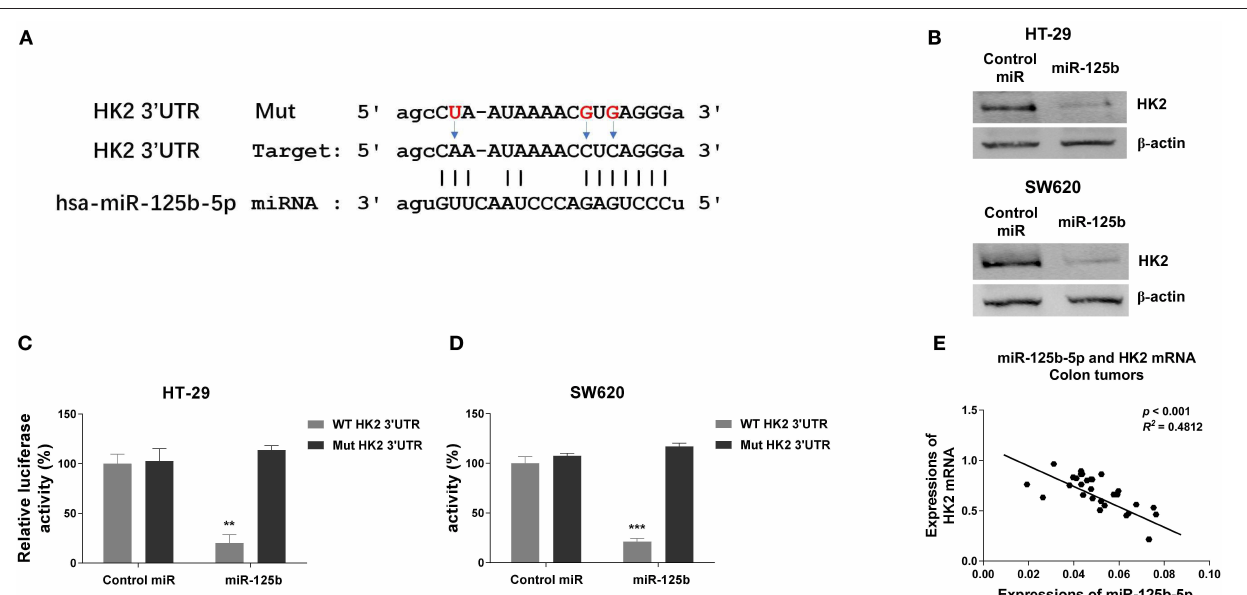
FIGURE 5 | Hexokinase 2 is a direct target of miR-125b-5p in colon cancer. (A) The predicted binding sites of miR-125b-5p on 3 ′ UTR of HK2. (B) HT-29 and SW620 cells were transfected with control miR or miR-125b-5p for 48h. The protein expressions of HK2 were detected by Western blot. (C) HT-29 and (D) SW620 cells were cotransfected with luciferase reporter vectors containing WT-3 ′ UTR or mutant 3 ′ UTR of HK2 and control miR or miR-125b-5p. The relative luciferase activity was measured by luciferase assay. (E) A negative correlation between HK2 mRNA and miR-125b-5p expressions was observed from colon cancer tissues. Data are presented as mean ± SD. * p < 0.05, ** p < 0.01, and *** p < 0.001.